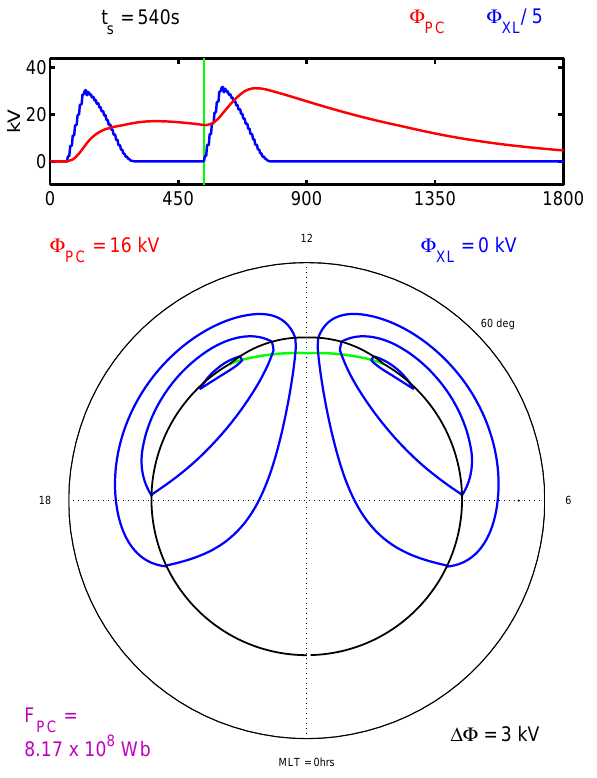
Fig. 2. Model output boundary characteristics corresponding to Fig. 1. The top panel shows the latitude as a function of MLT, of the OCB (solid line), 3 0 , and the equilibrium boundary (dash- dot line), 3 E . The middle panel shows the poleward convection velocity at the OCB, V cn , caused by the motion of the boundary. The bottom panel shows the electrostatic potential around the OCB, 8 OCB . The vertical dashed line in each panel marks the centre of the merging gap, at 12:00 MLT, and the dotted lines mark the maxi- mum extent of the merging gap. These lie at 10:00 and 14:00 MLT. Note that the perturbation to the equilibrium boundary has propa- gated to the points marked s and r